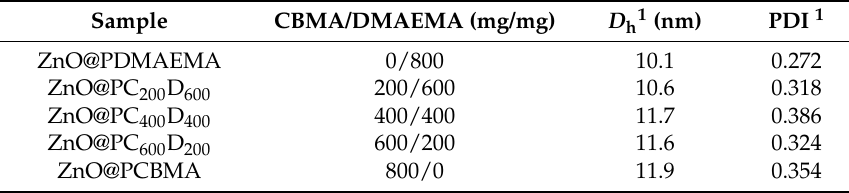
Table 1. Structural parameters of different